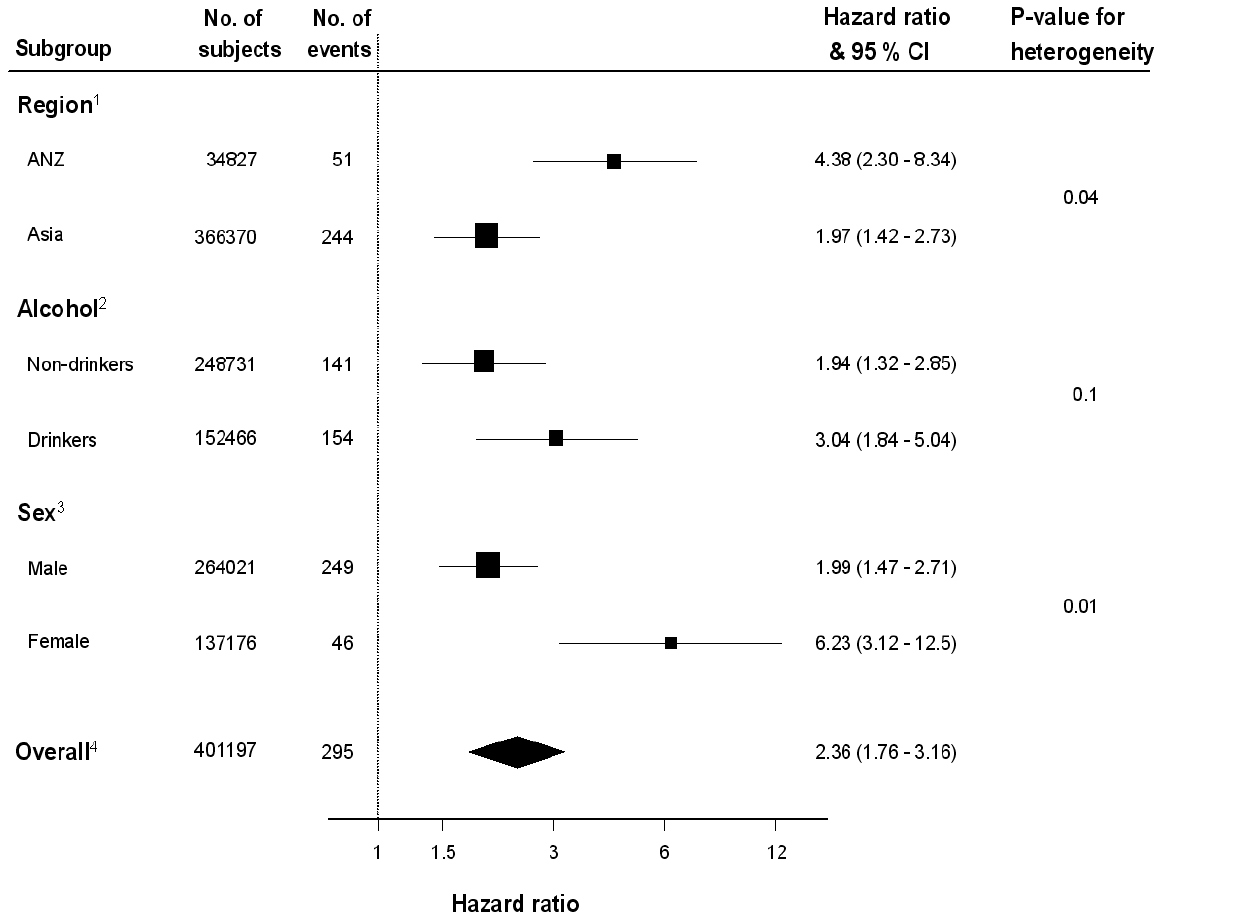
Figure 1. Hazard ratios for death due to upper aero digestive tract cancer for current smokers compared with those who have never smoked by subgroups and